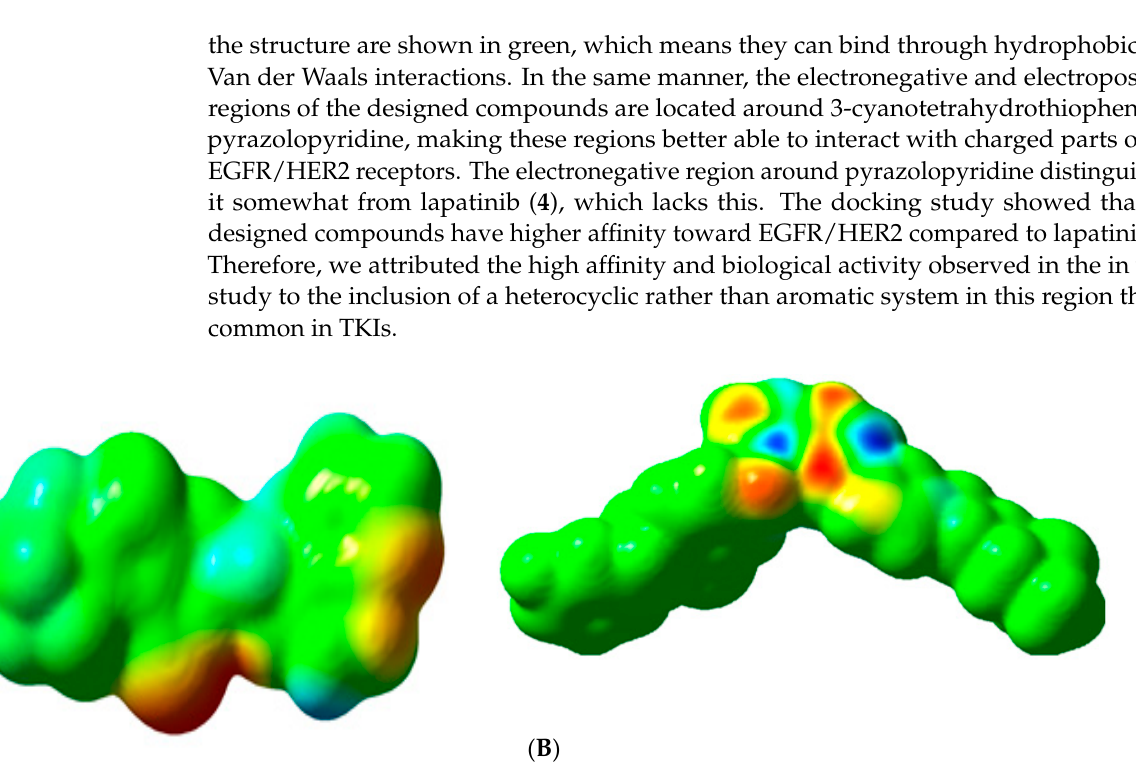
Figure 7. Molecular electrostatic potential mapping for ( A ) the most potent compound ( 21a ) and ( B ) lapatinib ( 4 ) from density functional theory (DFT) calculations. Green indicates zero potential regions, blue indicates electropositive regions, and red indicates electronegative regions.